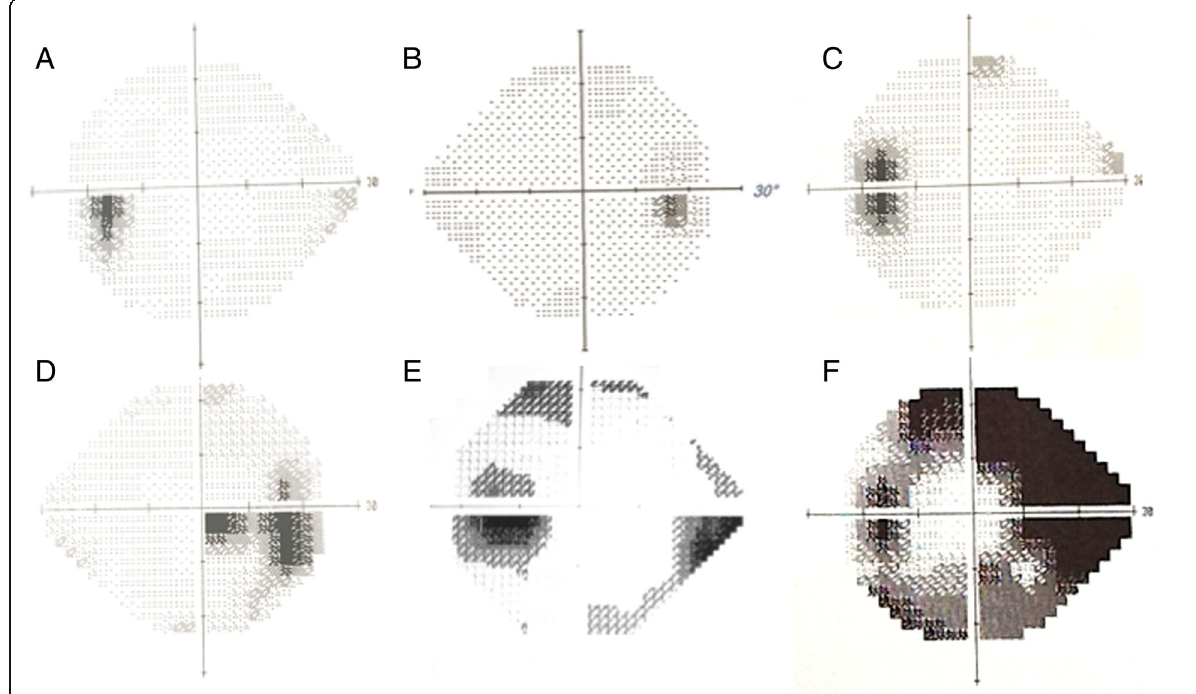
Fig. 2 Typical visual field defects in IIH. Common visual field defects seen in IIH with the Humphrey visual field analyser grey scale. a , Left eye with a slightly enlarged blind spot; b , right eye with slightly enlarged blind spot; c , Left eye obvious enlarged blind spot; d , right eye with enlarged blind spot and paracentral scotoma; e , left eye with enlarged blind spot and prominent inferior nasal step; f , Left eye with enlarged blind spot, dense superior and inferior arcuate